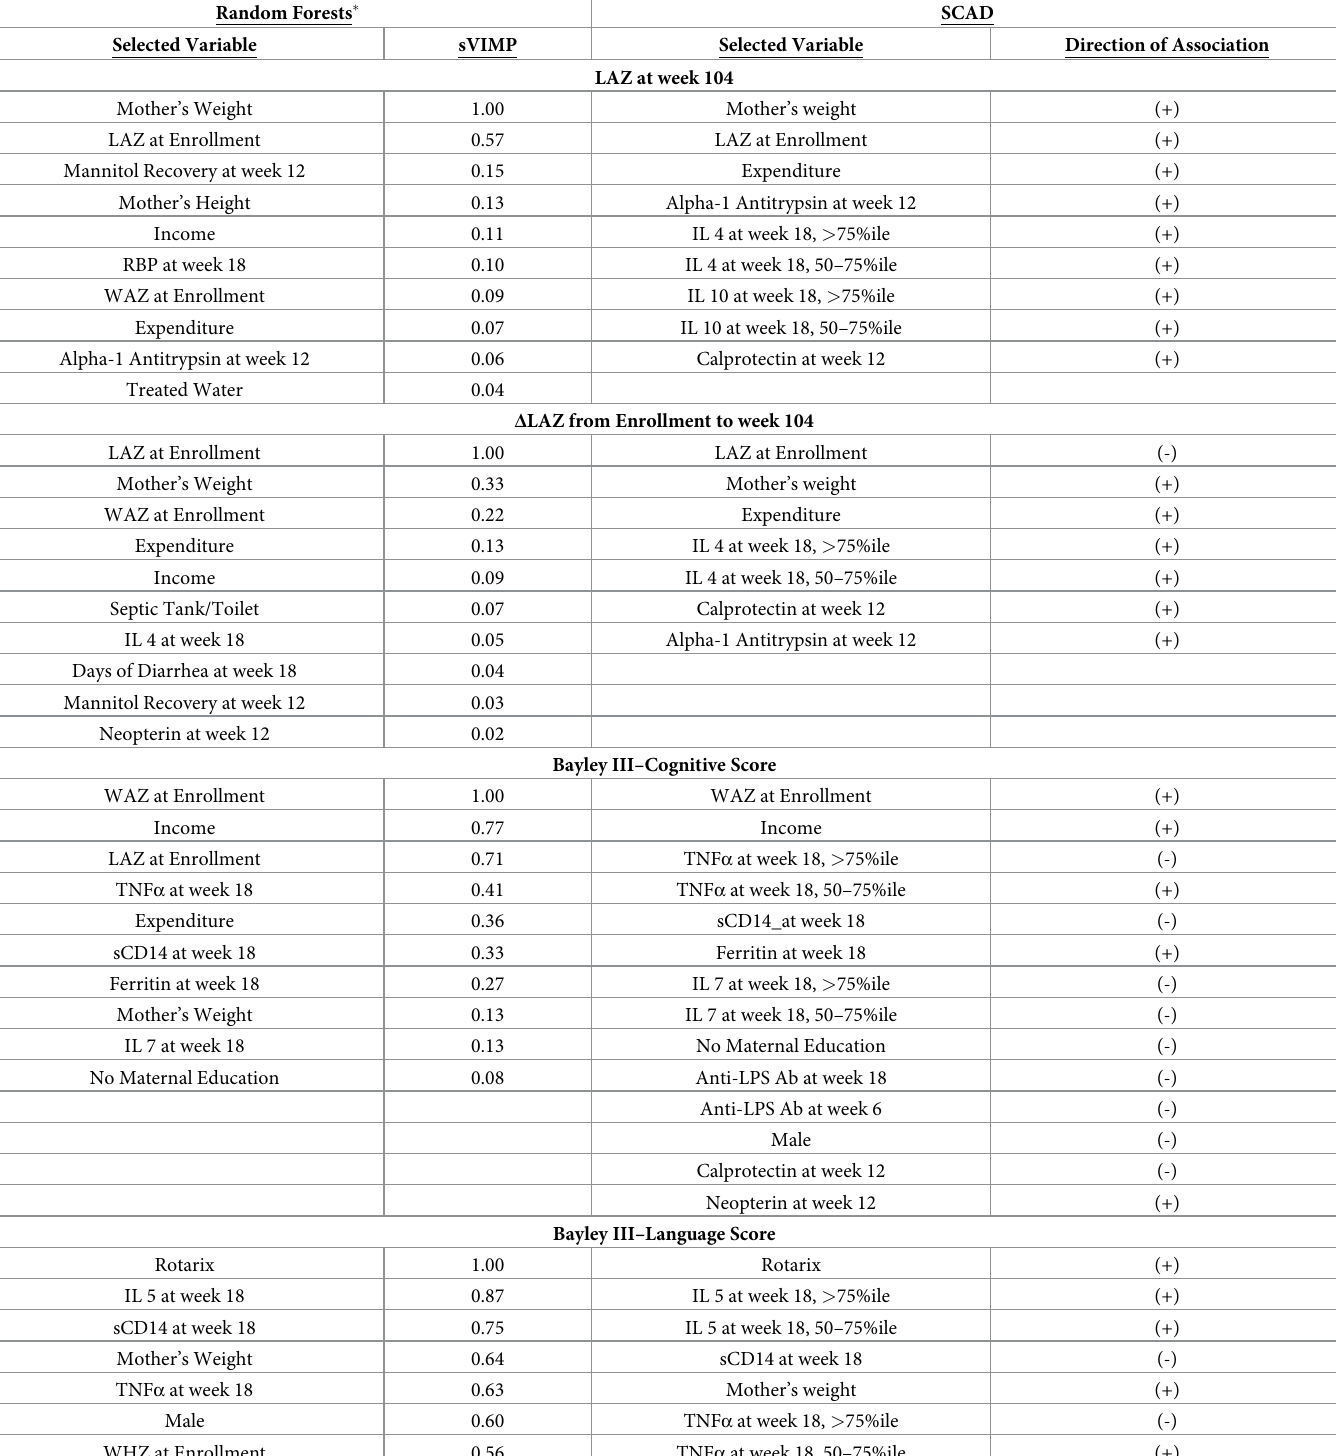
Table 3. Variables selected by both random forest (top 10 selected variables) and SCAD (all selected variables) analyses for the outcomes of linear growth and per- formance on the Bayley III scales of infant and Toddler Development. Random Forests